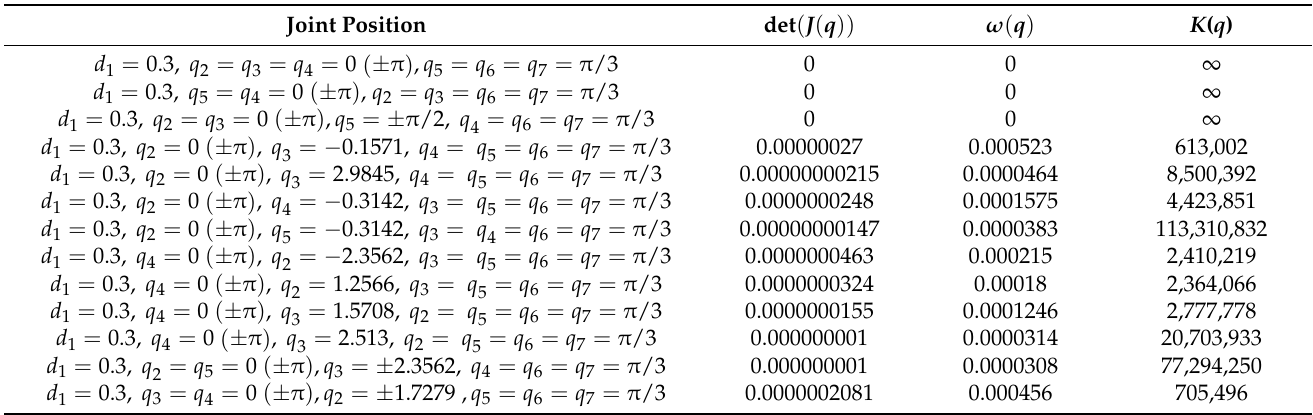
Table 3. det ( J ( q )) , ω ( q ) , and K ( q ) with singularity and approximate singularity. Joint